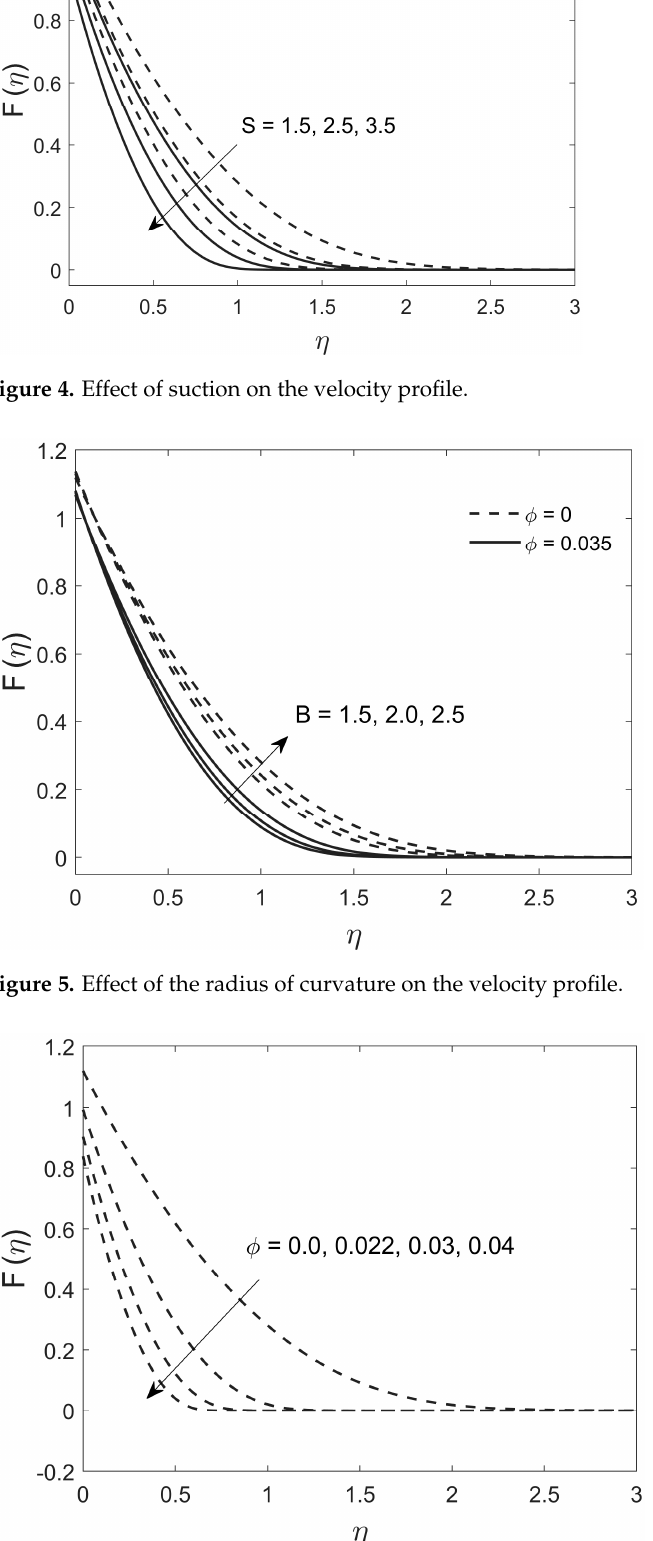
Figure 6. Effect of the nanoparticle volume fraction on the velocity profile.